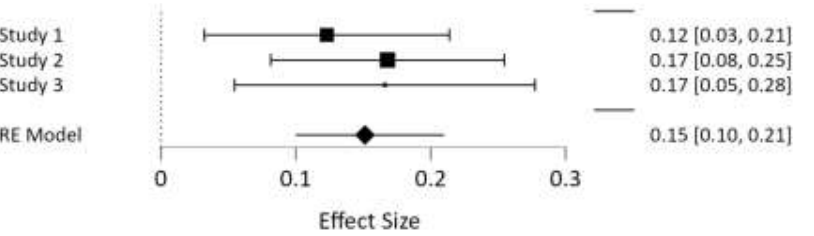
Figure 20. Forest plot of meta-analysis of Motivation for stimulation and Intellect